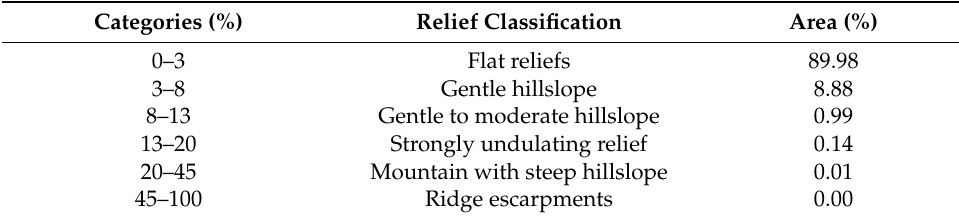
Table 3. Slope steepness categories for the Brazilian Cerrado by [75].